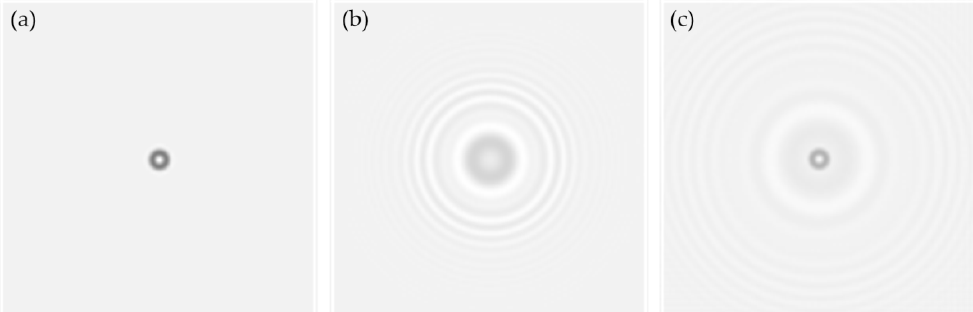
Figure 4. The twin-image problem: ( a ) a 7 μ m micro-bead image was used to simulate the reconstruction of lens-less holographic images. ( b ) By simulating the holographic imaging with Equations (1)–(4), we retained the amplitude of the complex number and discarded the phase to simulate the recording procedure of a CIS. ( c ) We used Equation (6) to reconstruct the focus image of object plane, but it was polluted by the twin-image phenomenon.